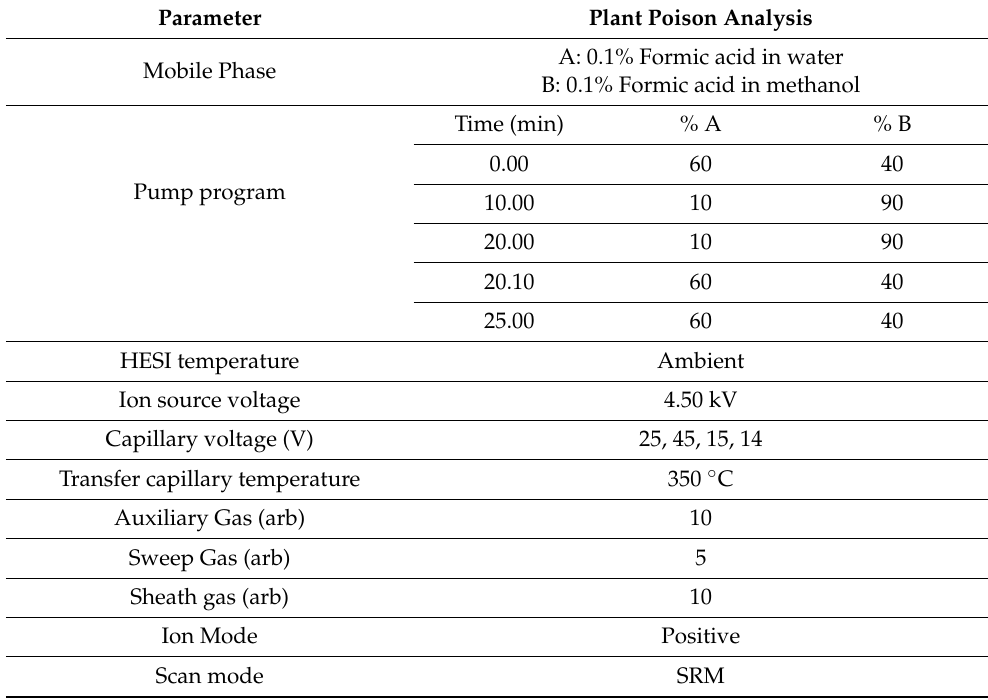
Table 1. LC-MS instrument